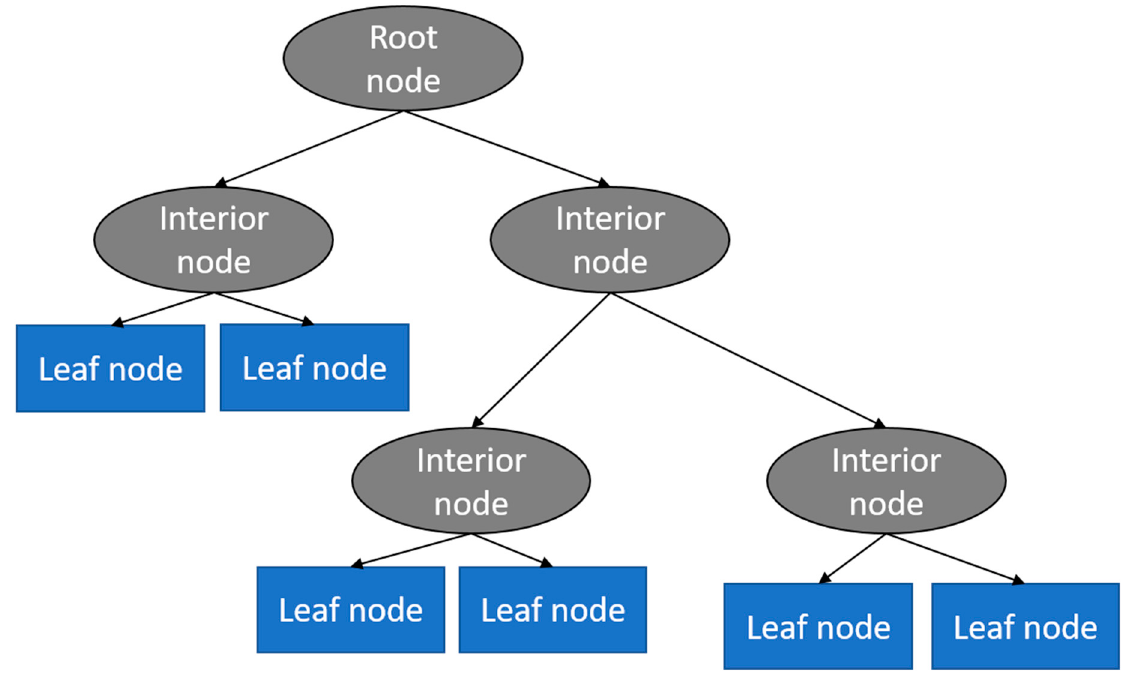
Figure 3. DT visualization.